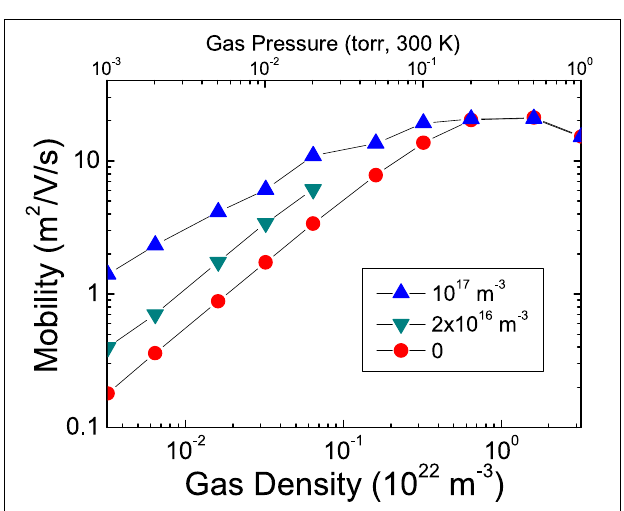
FIGURE 15 | Calculated steady state cross-field mobility as a function of xenon gas density for different values of the average plasma density n 0 , and for E 0 = 2 × 10 4 V/m and B 0 = 2 × 10 − 2 T. The circle symbols corresponds to the classical cross-field electron mobility (no instability), obtained for low plasma densities, and the triangle symbols correspond to the electron mobility enhanced by the instability for n 0 = 2 × 10 16 m − 3 and n 0 = 10 17 m − 3 . These results show that the anomalous mobility due to the electron-cyclotron drift instability is a strong function of the plasma